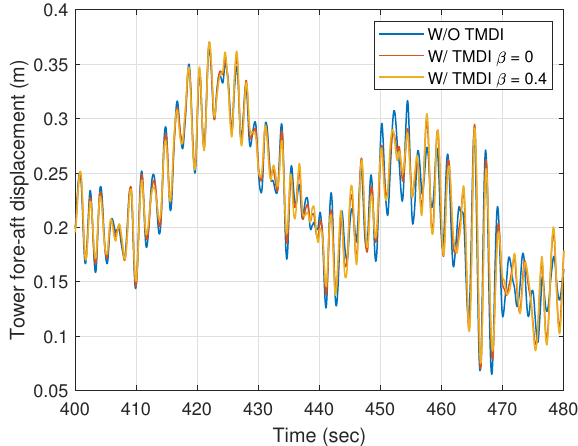
Figure 11. Tower fore-aft displacement.